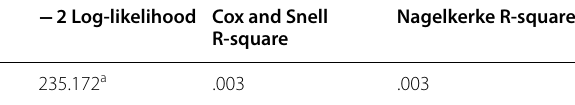
Table Q: Omnibus tests of model coefficients stability